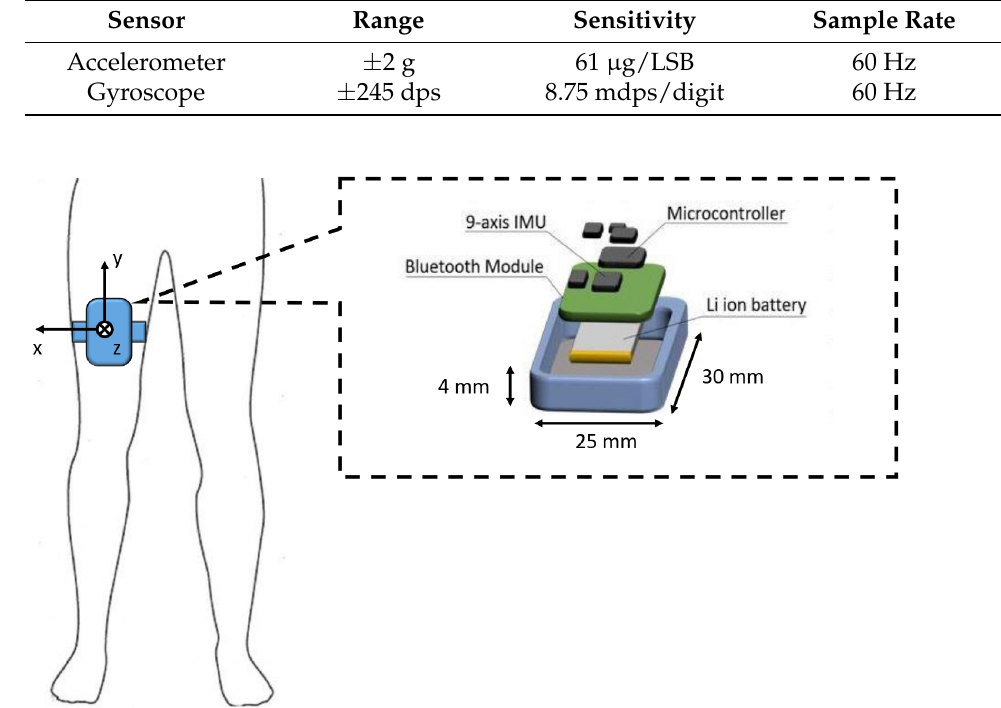
Figure 1. Sketch of sensor position, together with an exploded view of the neMEMSI